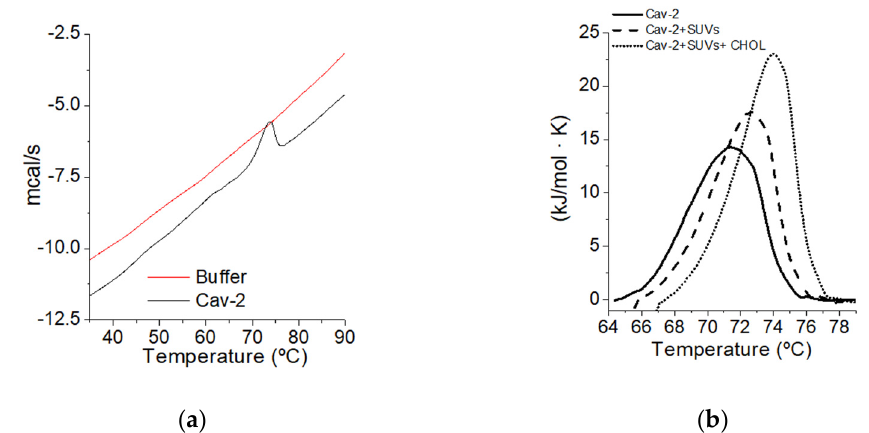
Figure 3. Cav-2 (120 μ M) was prepared and run against buffer: sodium phosphate buffer 25 mM pH 7. to adjust optional conditions above the noise (panel a ). After buffer subtraction, a comparison of the signal between this signal (continuous line) and that obtained in the presence of SUVs (1.2 mM) (dashed line) and SUVs (1.2 mM) in the presence of cholesterol (5%) (dotted line) was performed (panel b ). Differential scanning calorimetry measurements were carried out using a Nano DSC TA differential scanning calorimeter, operated with 700 μ L of the sample at a scanning rate of 0.5 °C/min. The DSC spectra shown in this figure are representative of triplicate experiments.